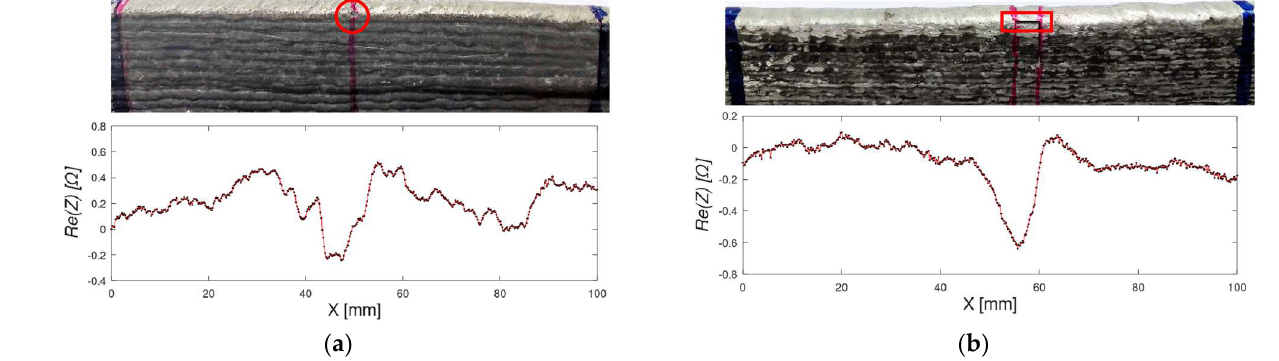
Figure 21. Manually wound customized ECT probe impedance output obtained from the inspection of an aluminum sample at a frequency of 1.5 kHz with: ( a ) a 1 mm diameter defect; ( b ) WEDM slot defect. The red circle and rectangle indicate the defects in the WAAM parts.